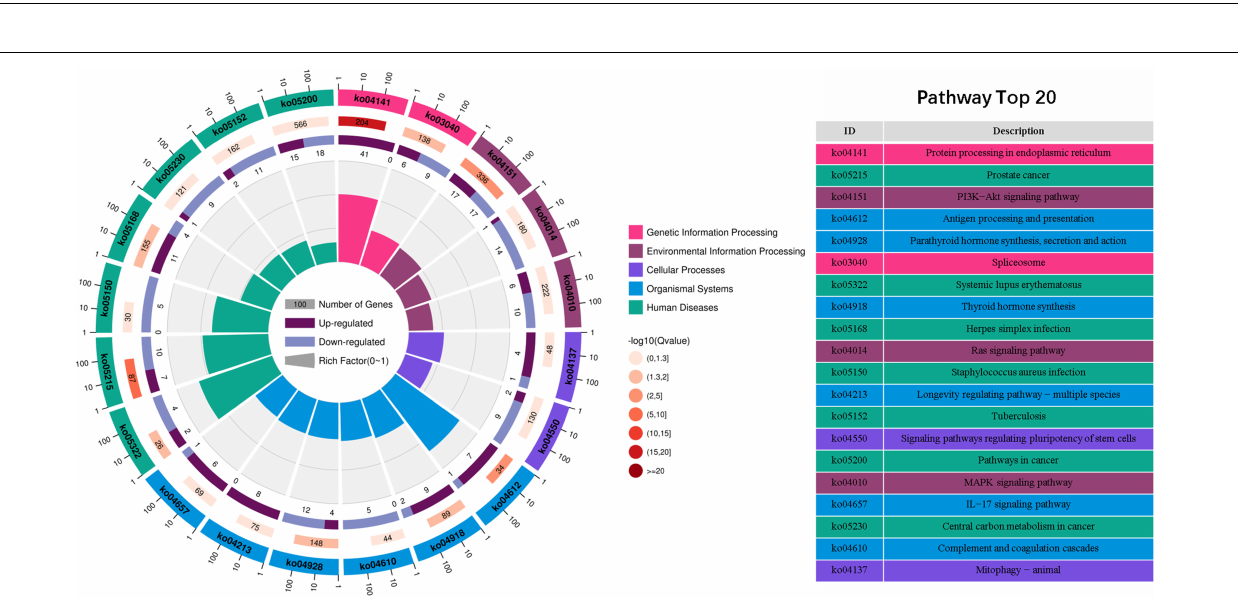
FIGURE 4 | Circular map of top 20 KEGG pathways enriched in the differentially expressed genes (DEGs) between 48 h_HS and CO groups. The first (outer) circle: different colors represent different KEGG A-classes: genetic information processing, environmental information processing, cellular processes, organismal systems, and human diseases. The second circle: the number shows the background gene numbers enriched in this pathway, the higher the number, the longer of the bar; depth of color represents the q -value, the smaller the q -value, the deeper of the color. The third circle: dark purple bar represents the number of up-regulated DEGs enriched in this pathway, and the light purple bar represents the number of down-regulated DEGs enriched in this pathway. The fourth (inner) circle shows the rich factor value of each pathway (the number of DEGs enriched in each pathway divided by all the numbers of background genes enriched in this pathway). In the fourth circle, each grid of the background grid line represents